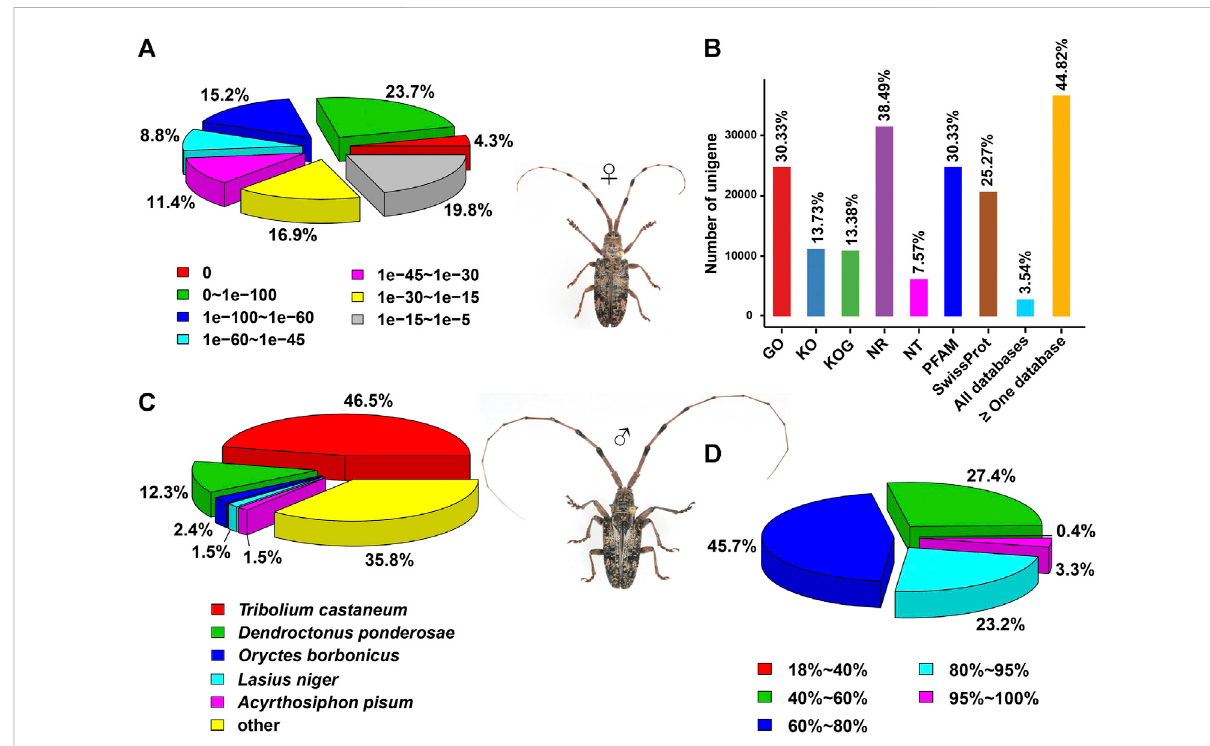
FIGURE 2 Annotation of the transcriptome in P. antennata illustrating the E -value distribution (A) , database annotation (B) , species classi fi cation (C) , and similarity distribution (D) .